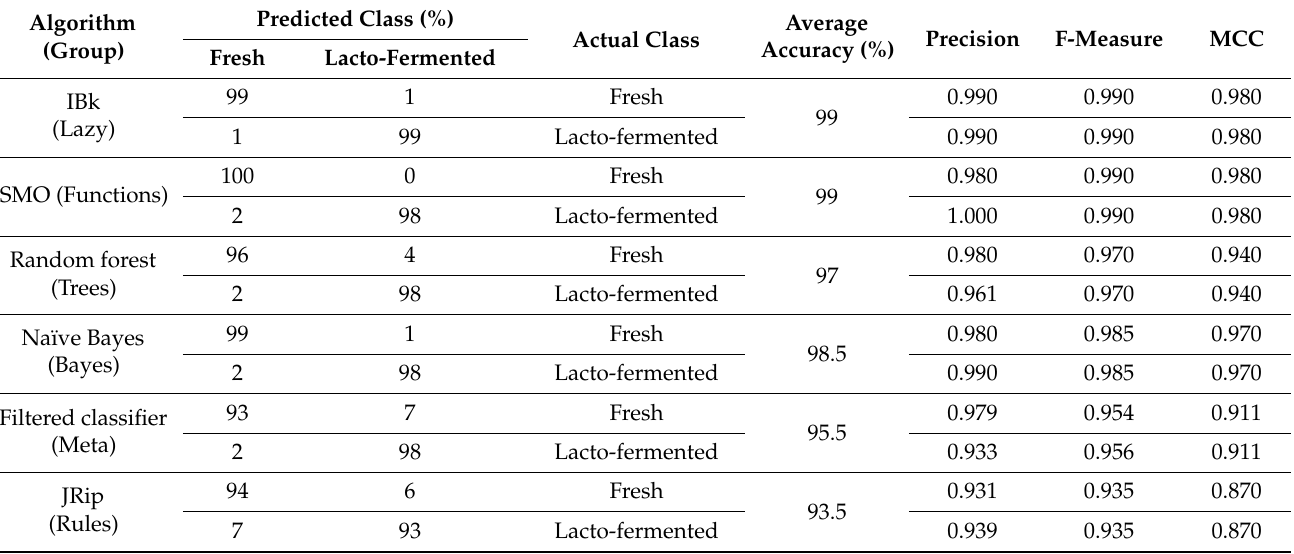
Table 7. The results of distinguishing fresh and lacto-fermented red bell pepper samples using selected image textures from color channel X